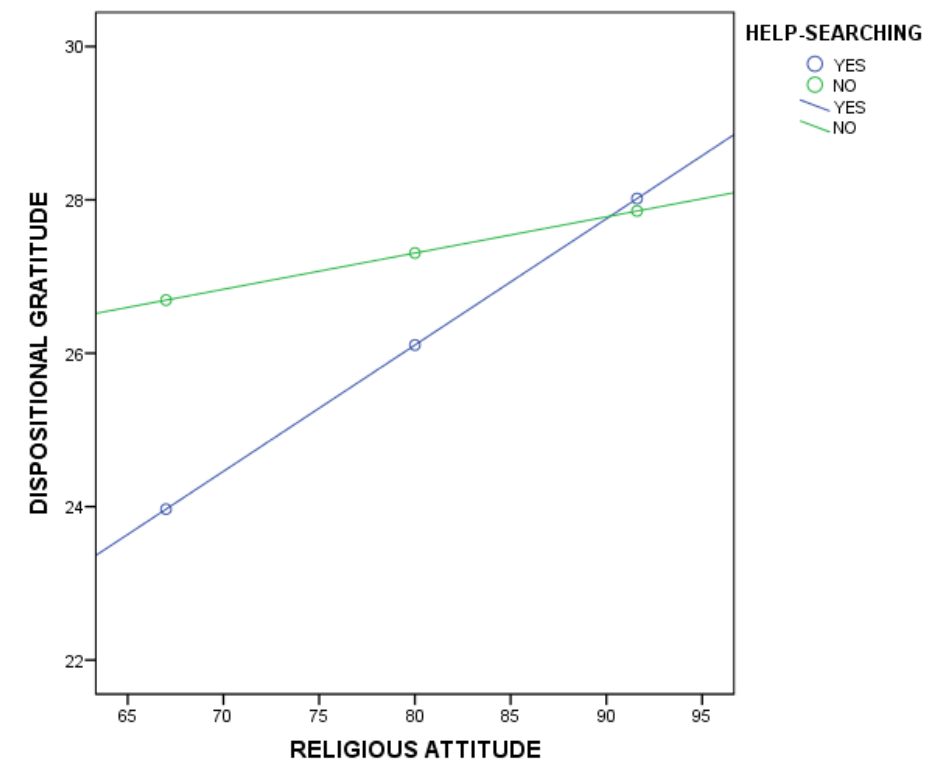
Figure 2. Plot of the slope analysis for the moderating effect of seeking help in the relationship of religiosity and gratitude among homeless people.